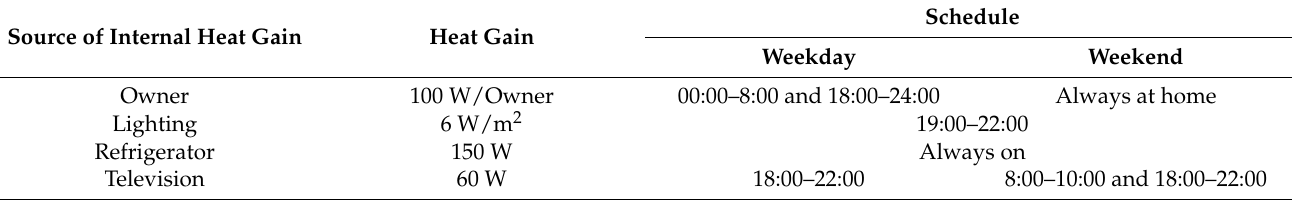
Table 4. Internal heat gains.